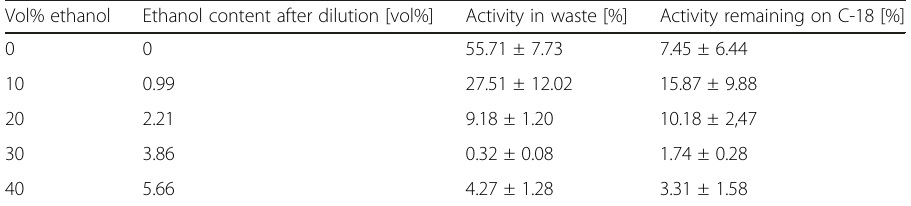
Table 2 Ethanol content after dilution of the reaction mixture and corresponding activity found in the waste fraction after C-18 trapping as well as on C-18 after elution of the product Vol% ethanol Ethanol content after dilution [vol%] Activity in waste [%] Activity remaining on C-18 [%]